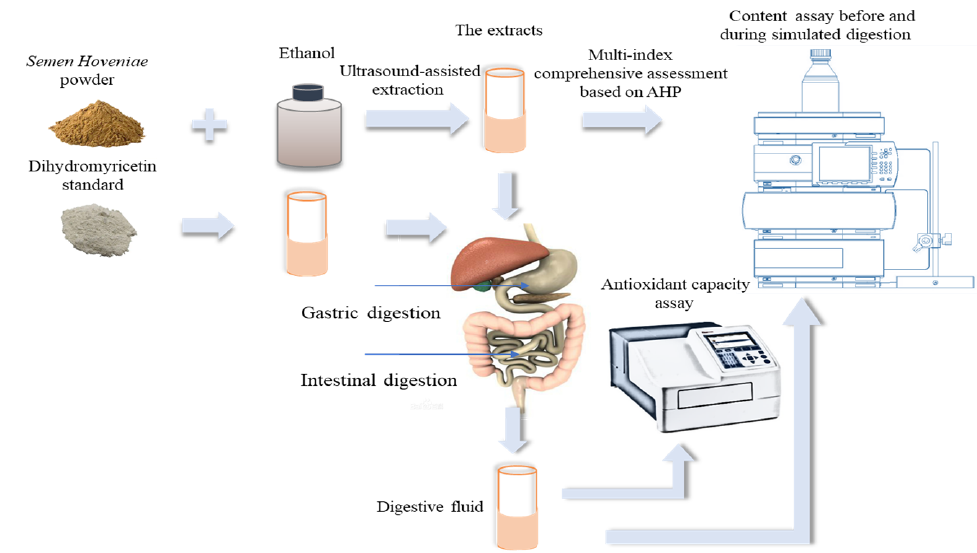
Figure 1. The illustrative design of the present research. Including three sections: optimized extraction process, simulated gastrointestinal digestion and evaluated of extracts, simulated gastrointestinal digestion and evaluated of the dihydromyricetin standard.